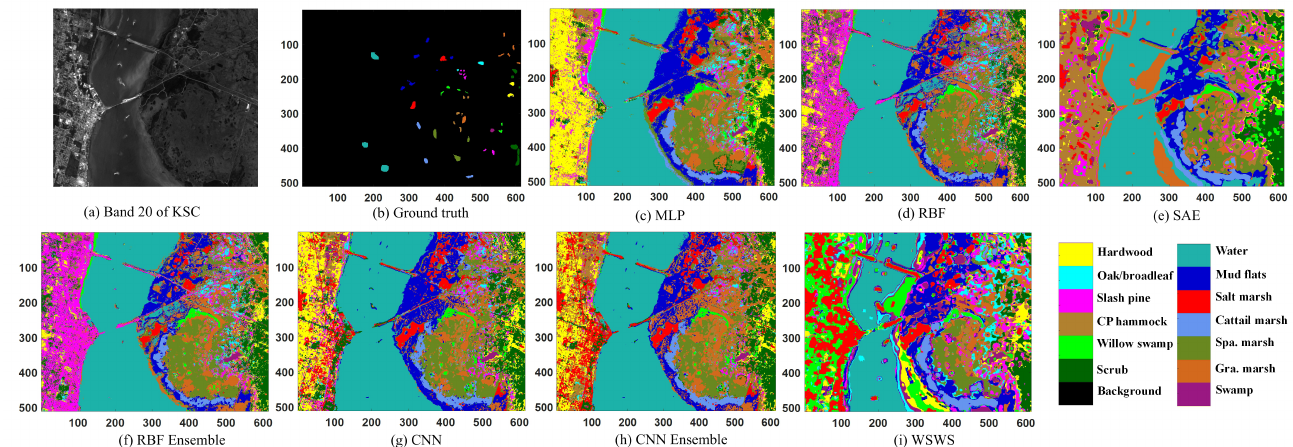
Figure 5. Classification results of KSC data. ( a ) Original image, ( b ) ground truth (there are no class labels for the black background), ( c ) MLP, ( d ) RBF, ( e ) SAE, ( f ) CNN, ( g ) RBE ensemble, ( h ) CNN ensemble, and ( i )